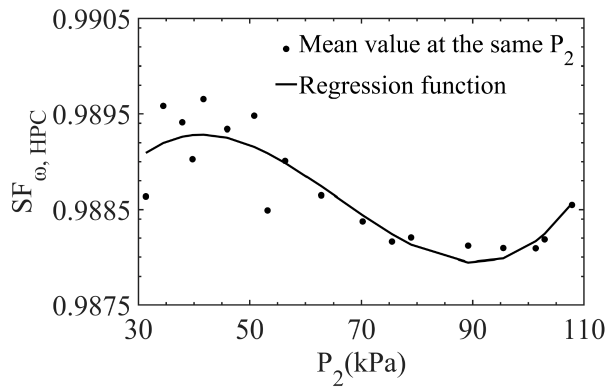
Figure 9. Regression analysis result of the mapping relationship: Case 3.